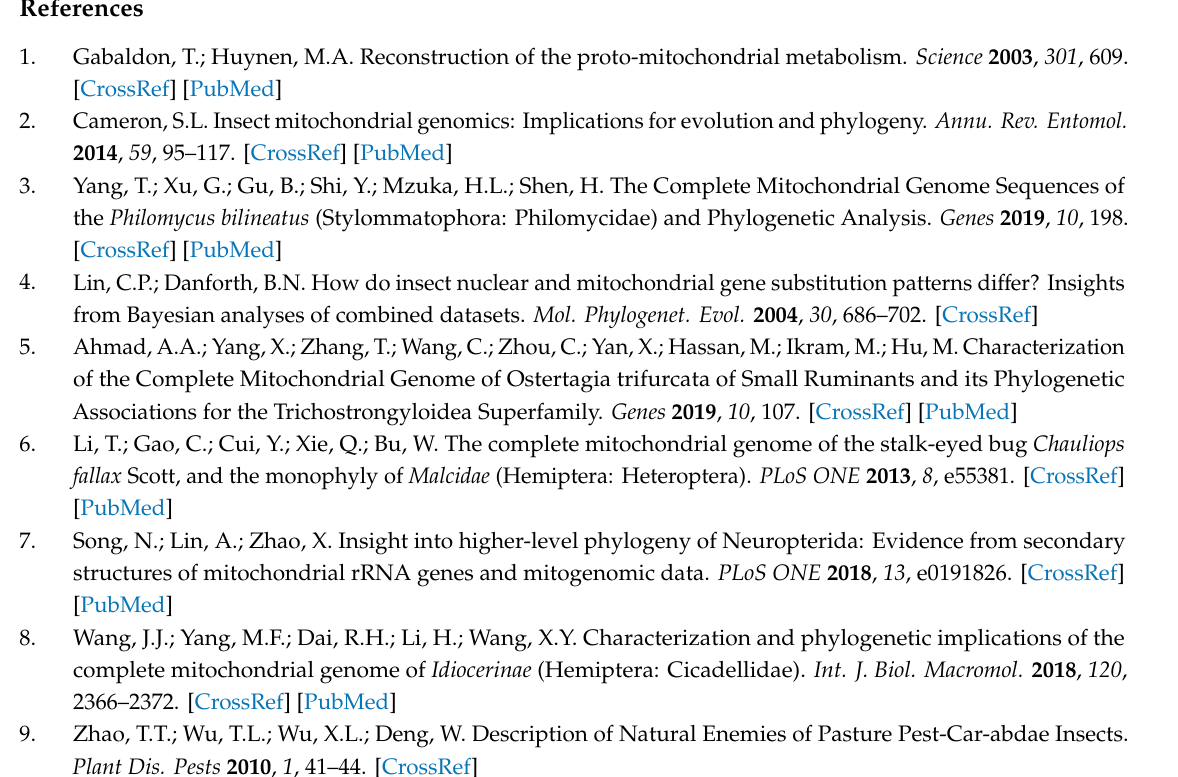
Table S1: NCBI accession number. Table S2: tandem